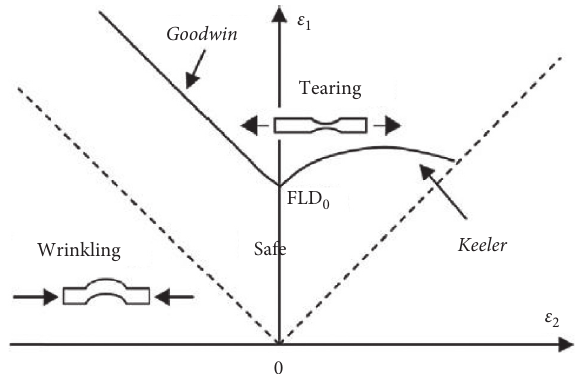
Figure 3: Fundamental representation sketch of forming limit diagram representing strains and different